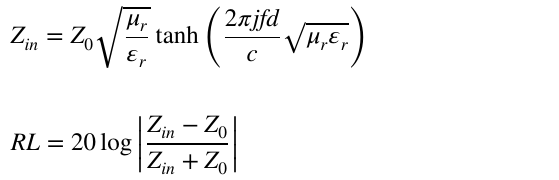
Fig. 3 N 2 absorption (red)–desorption (blue) isotherms with corresponding pore-size distributions in the inset for a TC-7, b ZC-7, c TZC-6, d TZC-7, e TZC-8, and f TZC-9. XPS spectra of TZC-7 and TZC-8: g O 1 s spectrum, h Ti 2p spectrum, and i Zr 3d